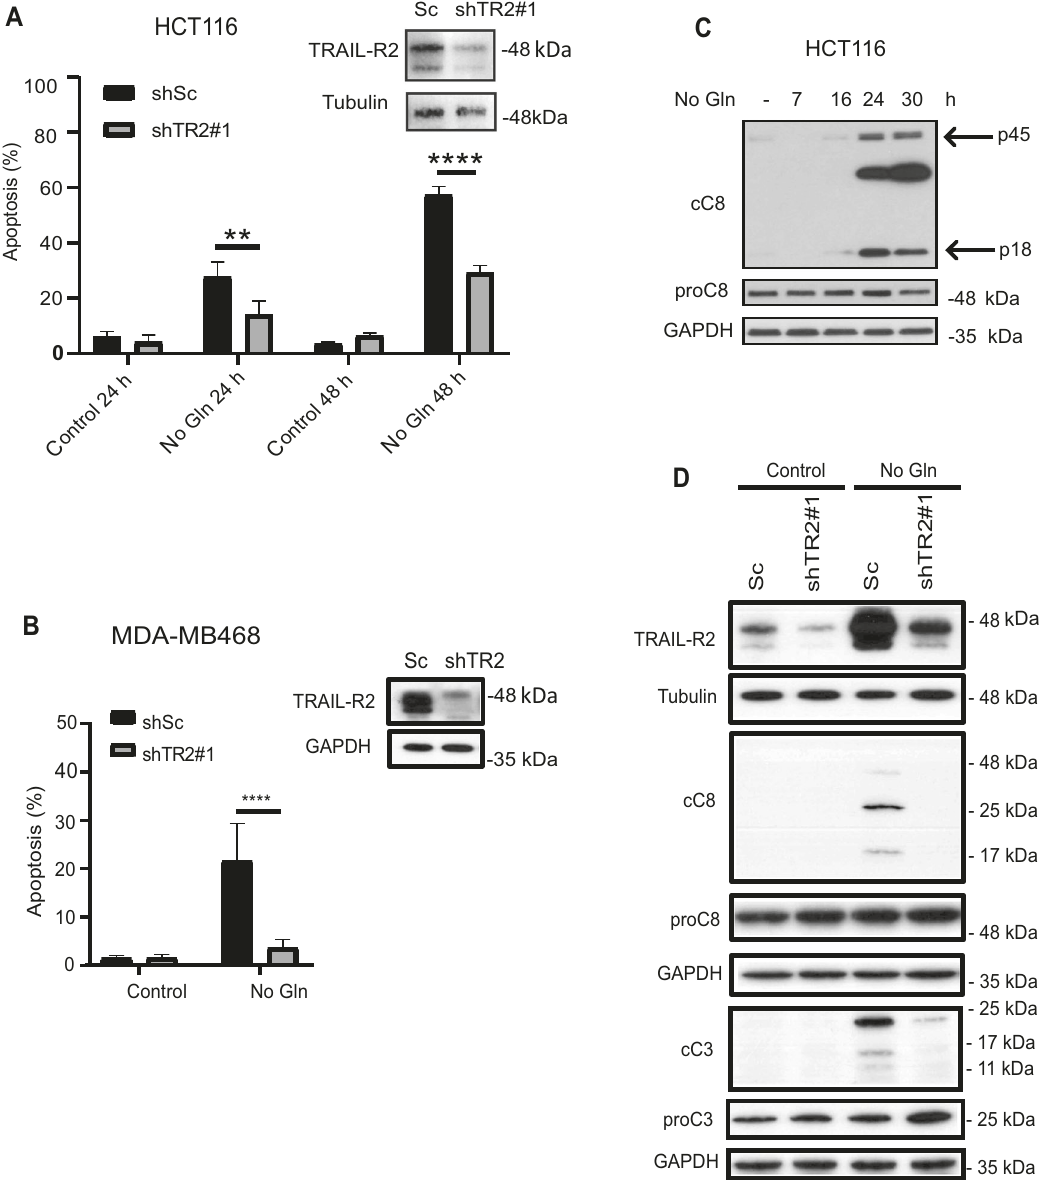
Fig. 4 Role of TRAIL-R2 in apoptosis induced by glutamine deprivation in tumor cells. A (HCT116) or B (MDA-MB468) cells stably expressing a scrambled (shSc) or a TRAIL-R2 targeting shRNA (shTRAIL-R2#1) were cultured with or without glutamine and apoptosis was assessed at the indicated times (HCT116) or 48 h (MDA-MB468). TRAIL-R2 knockdown was determined by Western blotting. Tubulin and GAPDH were used as protein-loading controls. Data are presented as mean ± SD from at least three independent experiments. ** P < 0.01; **** P < 0.0001;